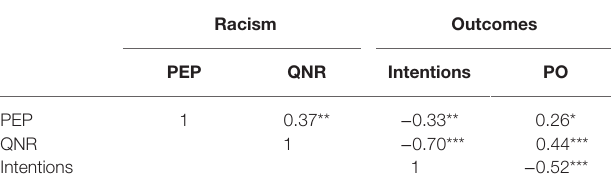
TABLE 1 | Correlations between PEP-based racism, questionnaire-based racism (QNR), and various outcomes in Experiment 1 (PO: Political Orientation).